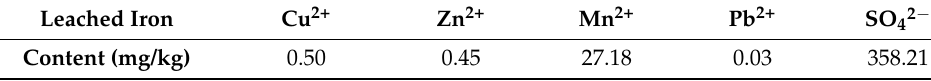
Table 2. Contents of heavy metal elements and SO 42– in sample